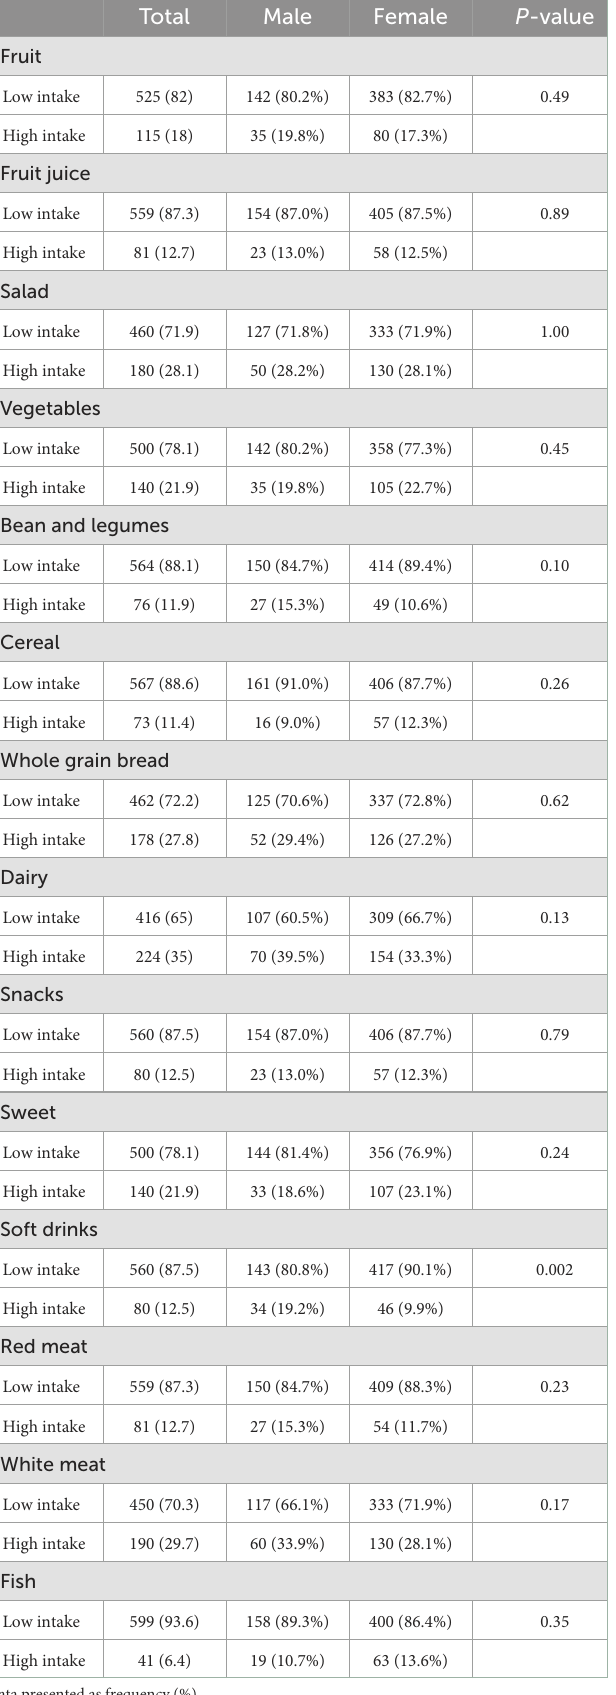
TABLE 2 Dietary intake based on gender of public schoolteachers. TABLE 3 Odds ratios and 95% CIs of food group intake according to physical activity levels of public